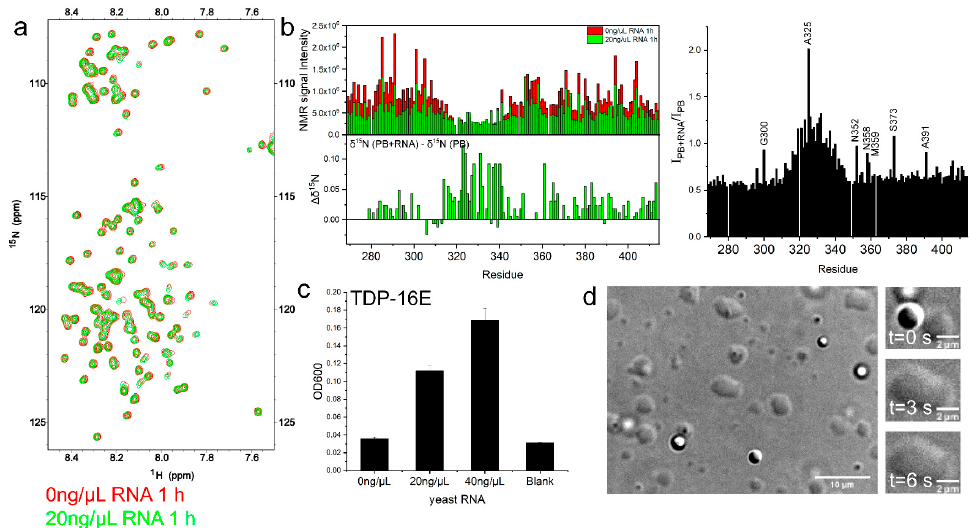
Figure 6. Effect of yeast RNA on the TDP-43 LCD liquid–liquid phase separation and protein aggregation. ( a ) The 1 H- 15 N HSQC spectra of 100 µ M TDP-43 LCD in pH 6.0, 10 mM phosphate buffer with 20 ng/ µ L yeast RNA (in green) or without yeast RNA (in red), obtained within 2 h from sample preparation. The temperature was 25 °C. ( b ) (Left) The NMR signal intensity comparison of the 1 H- 15 N HSQC of TDP-43 LCD (100 µ M) in pH 6.0, 10 mM phosphate buffer with (in green) or without 20 ng/ µ L yeast RNA (in red) and 15 N chemical shift changes of TDP-16 (100 µ M) upon adding 20 ng/ µ L yeast RNA in pH 6.0, 10 mM phosphate buffer. ∆ δ 15 N = δ 15 N (PB + RNA) − δ 15 N (PB). (Right) The NMR signal intensity ratio shown for all residues. ( c ) Turbidity (OD600 values) of the mutant TDP-16E (100 µ M) with different concentrations of yeast RNA. Error bars represent SD of three replicates. ( d ) Liquid-liquid phase separation of TDP-16E (100 µ M) with a concentration of 20 ng/ µ L yeast RNA detected by DIC microscopy. The right panel of ( d ) shows liquid-like droplet fusion in three time